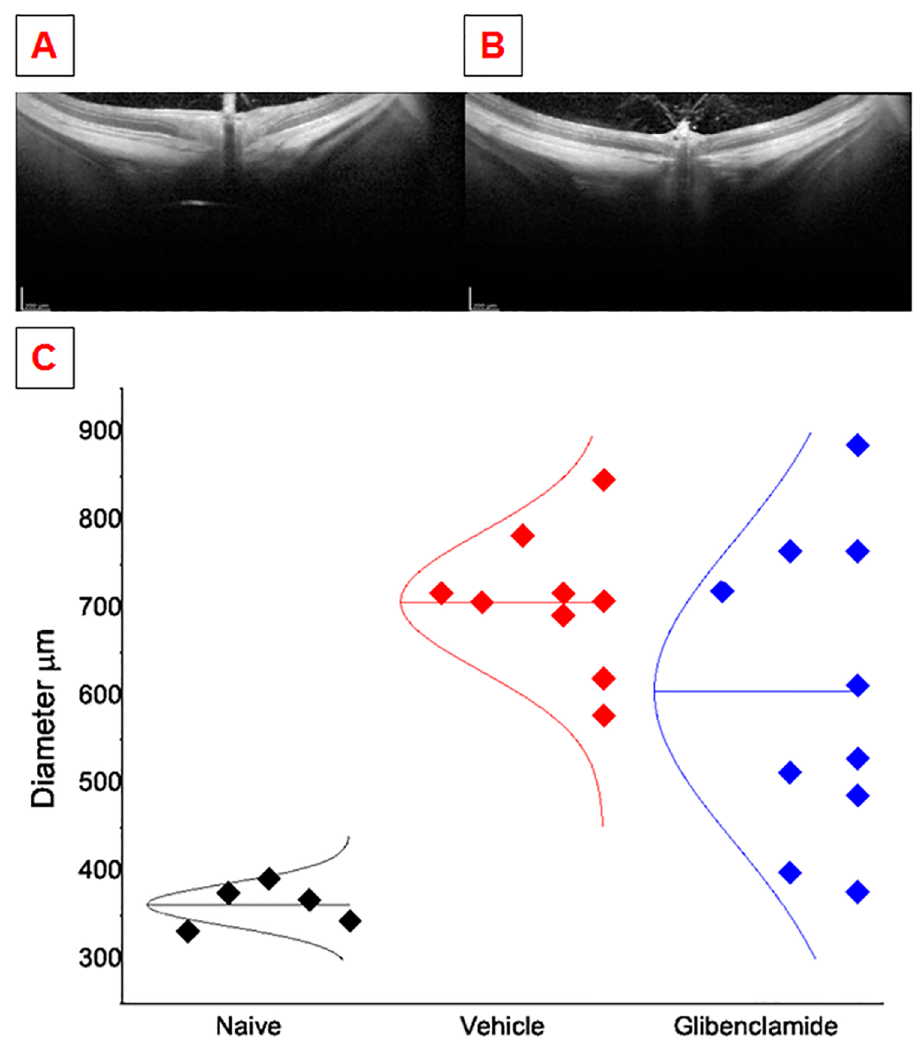
Fig 2. OCT comparison of rAION injured ONH treated with glibenclamide vs. vehicle. Panels A and B are typical images of rAION at 1 day post-injury treated with vehicle and glibenclamide, respectively. Panel C shows ONH edema measurements across rat ONH in naive rats compared with the edematous diameter with either glibenclamide or vehicle treatment. A normal curve is plotted over each category of data to indicate the mean and variance of the